Question: What type of chart is this?
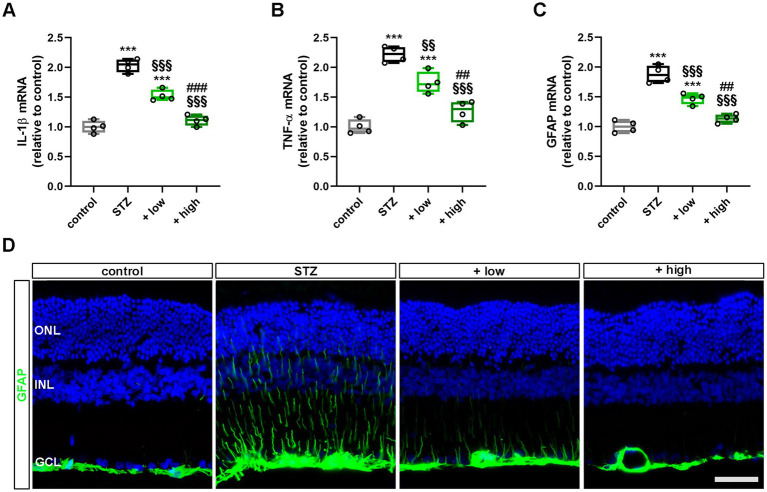
Answer: box